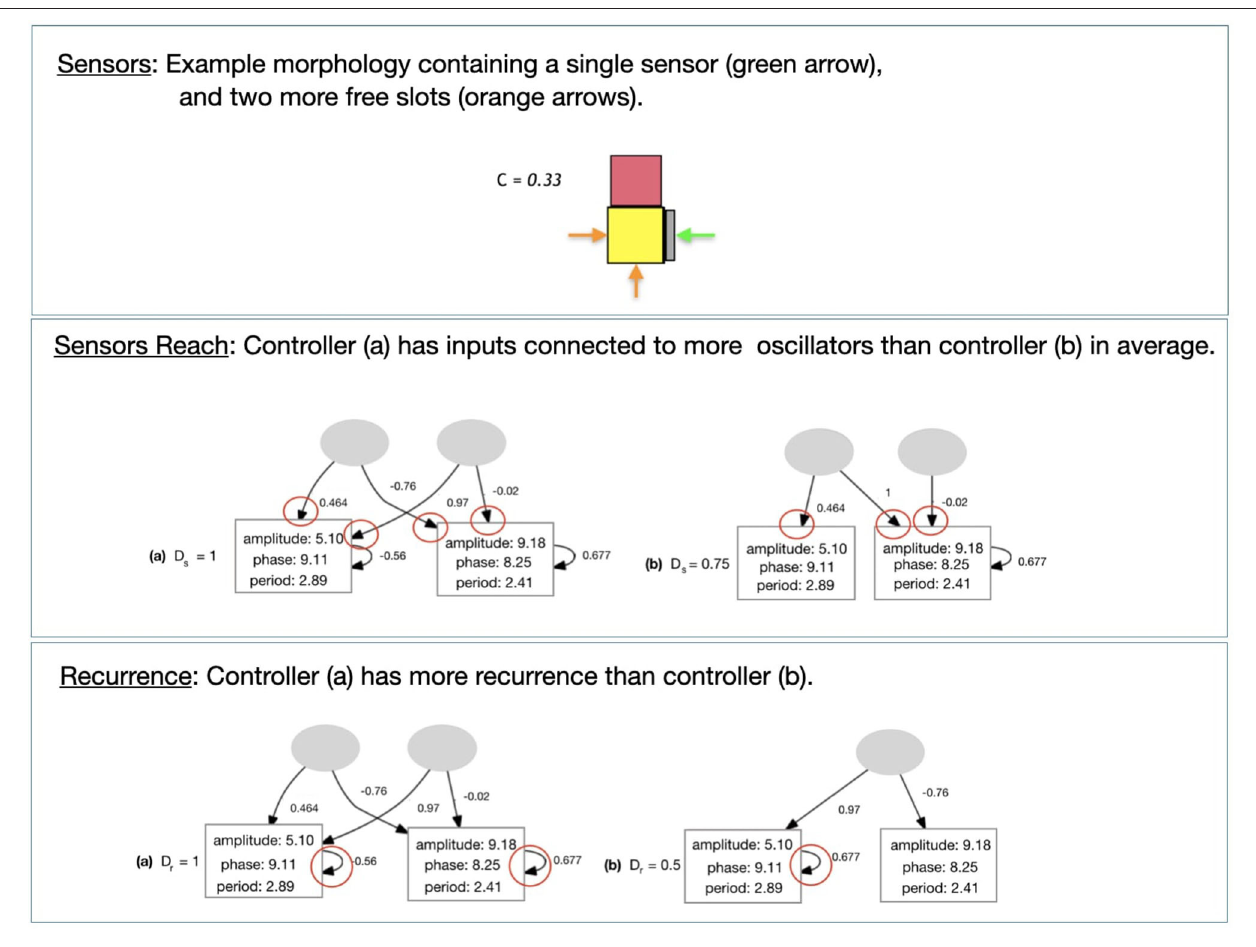
FIGURE 10 | Illustrations for the descriptors